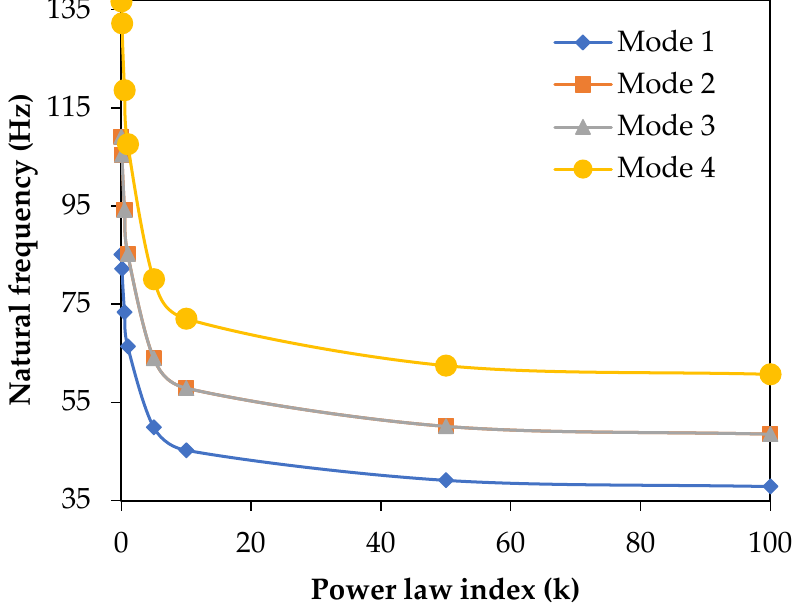
Figure 5. Variation of the natural frequency of the re-entry vehicle nose shell structures with the power law index for an aluminum/silicon carbide FGM structure for the first four modes.